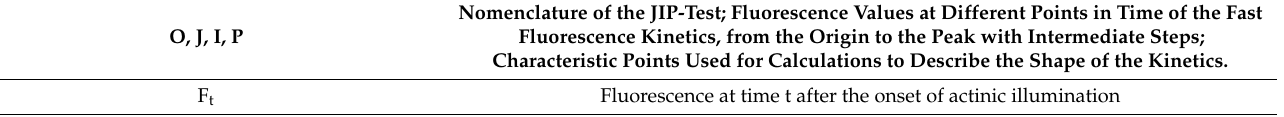
Table 1. Definitions of terms and formulas for the calculation of parameters from chlorophyll a fluorescence transient